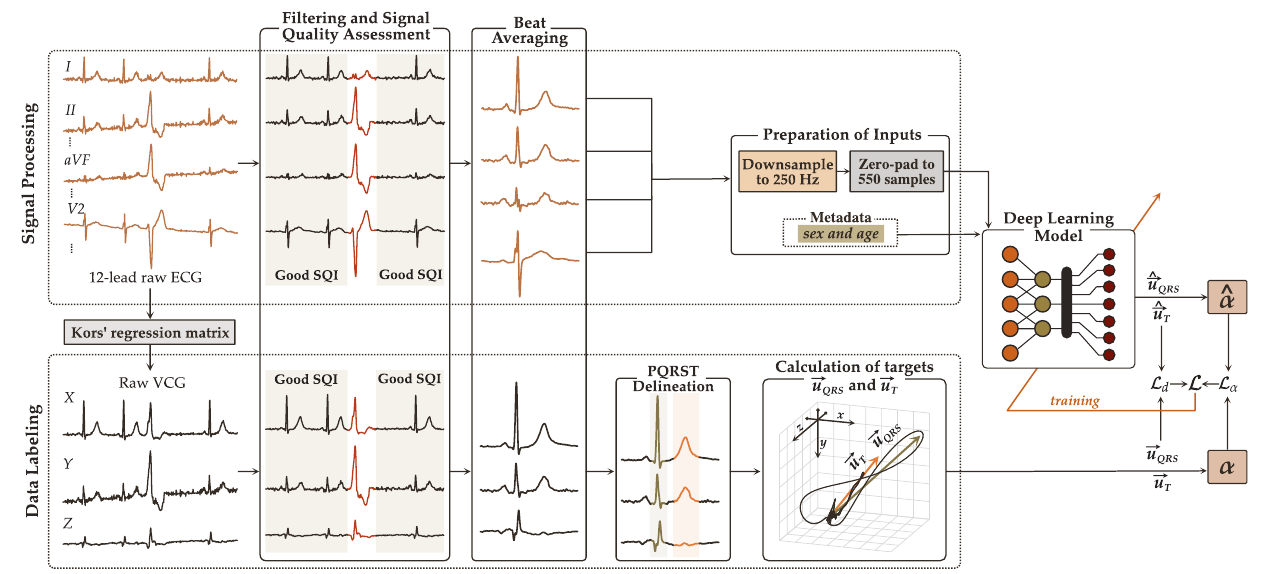
Figure 4. Data preparation and labeling. Signals undergo preprocessing to generate the input signal-averaged